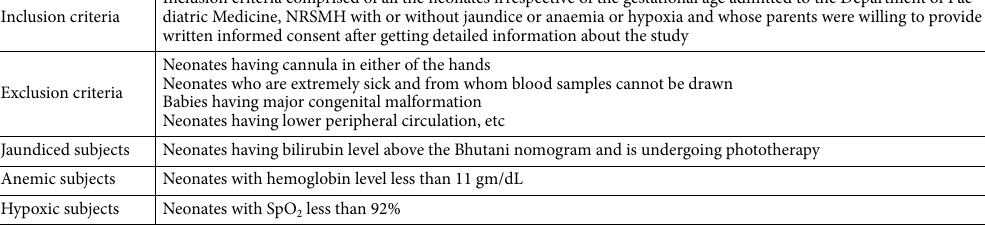
Table 3. Inclusion and exclusion criteria for the